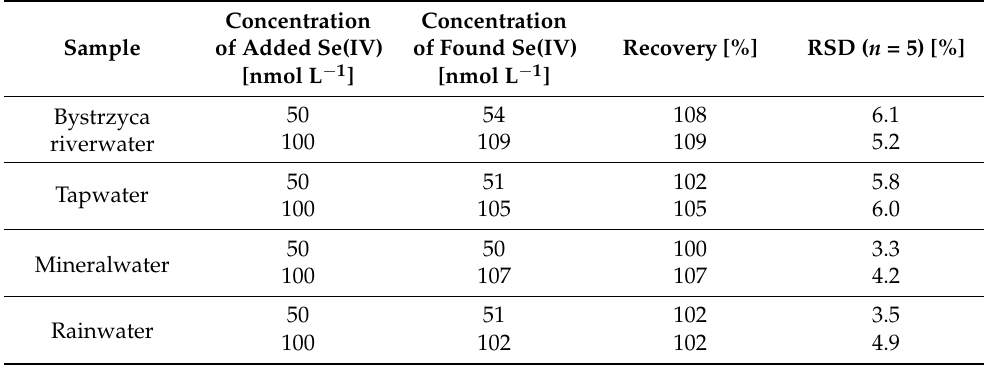
Figure 6. The voltammograms obtained in the course of selenium determination in certified water reference material TM-25.5: (a) blank (0.1 mol L − 1 acetic acid, 1.9 × 10 − 5 mol L − 1 Bi(III)); (b) as (a) + TM-25.5 (ten-fold dilution); (c) as (b) + 3.5 × 10 − 8 mol L − 1 Se(IV); (d) as (b) + 7 × 10 − 8 mol L − 1 Se(IV). Potential and time of deposition: − 1.6 V for 5 s followed by 0.4 V for 60 s. Table 5. Analytical results of Se(IV) determination in fresh natural water samples by the proposed procedure in the presence of 0.1 g Ambertite XAD-7 resin. The samples were analyzed after tenfold dilutions using standard addition